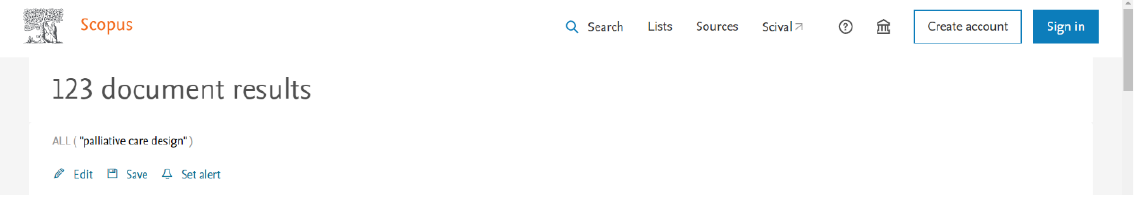
Figure 3: Results of the search query “Palliative care design” on the Scopus database